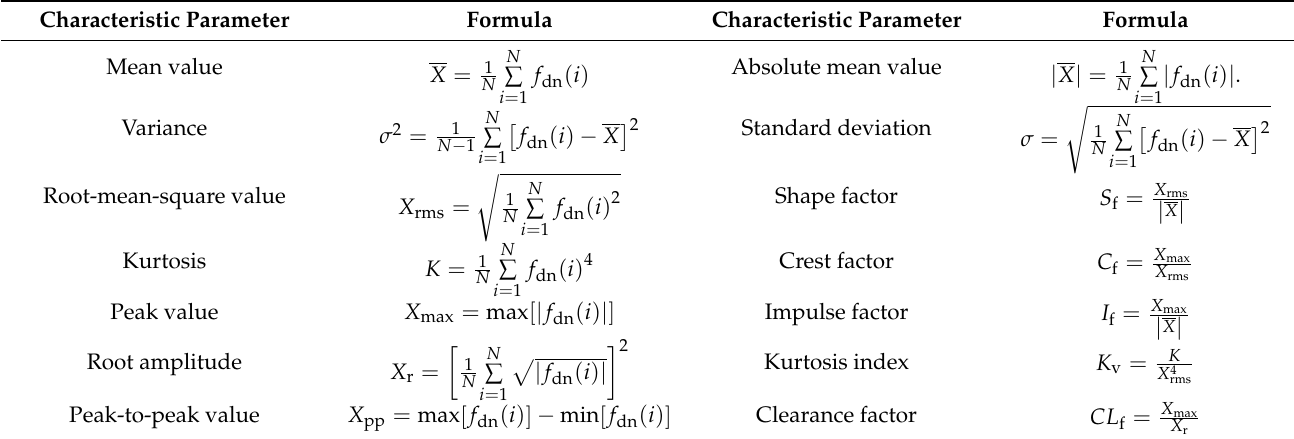
Table 1. Time-domain characteristic